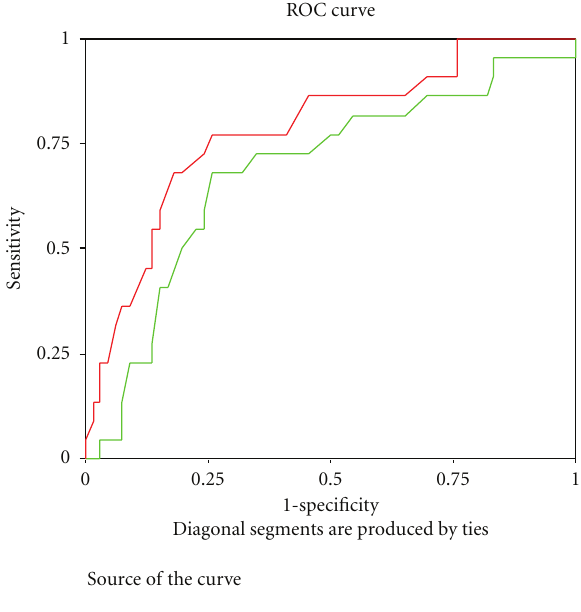
Figure 1: Receiver operating characteristics (ROC) curve of ADC values of peripheral prostatic zones (ADC of right peripheral zone: area under the curve: 0.781, P = 0 . 0001, 95% confidence interval: 0.666–0.895; ADC of left peripheral zone: area under the curve: 0.682, P = 0 . 011, 95% confidence interval: 0.547–0.816).